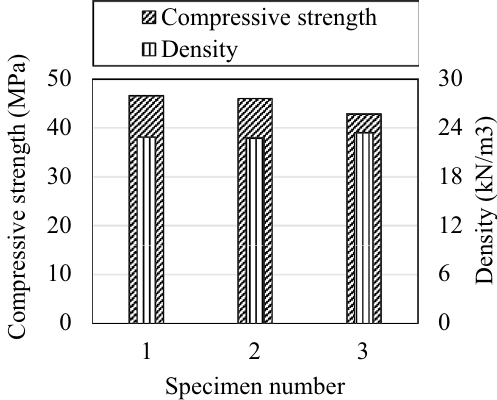
Fig. 4 Reinforced concrete properties used for the footing models